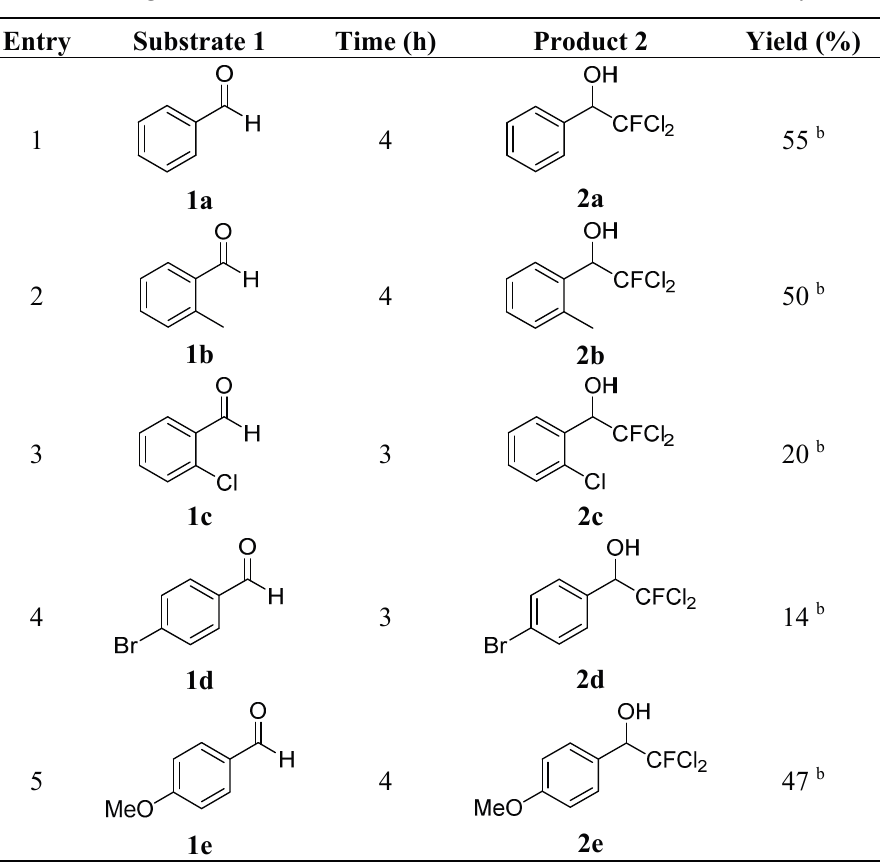
Table 1. Magnesium activated addition of CFCl 3 to aromatic aldehydes a